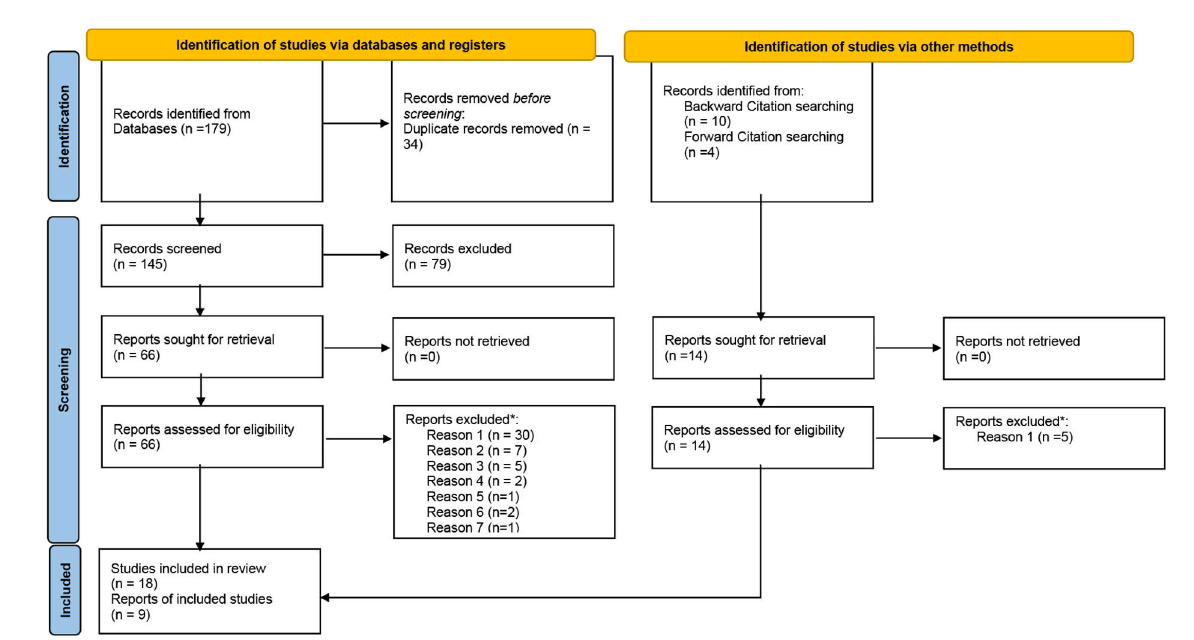
FIGURE1 PRISMA flow diagram . *Reason 1: Non-adaptation to the objective of the study from the perspective of its scope. Reason 2: Lack of originality. Reason 3: The research design is not clearly specified and appropriate for the aims and objectives of the research. Reason 4: The researchers don’t display enough data to support their interpretations and conclusions. Reason 5: The method of analysis is not appropriate and adequately explicated. Reason 6: The aims and objectives of the research are not clearly stated. Reason 7: The researchers don’t provide a clear account of the process by which their findings we